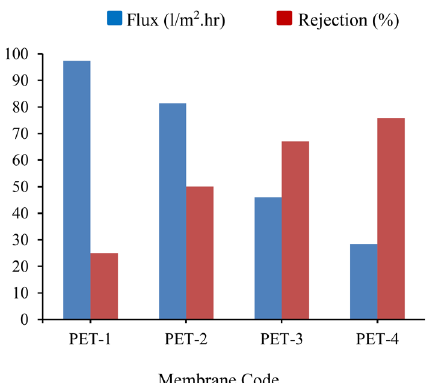
Figure 7. Molecular structure of polyvinyl pyrrolidone